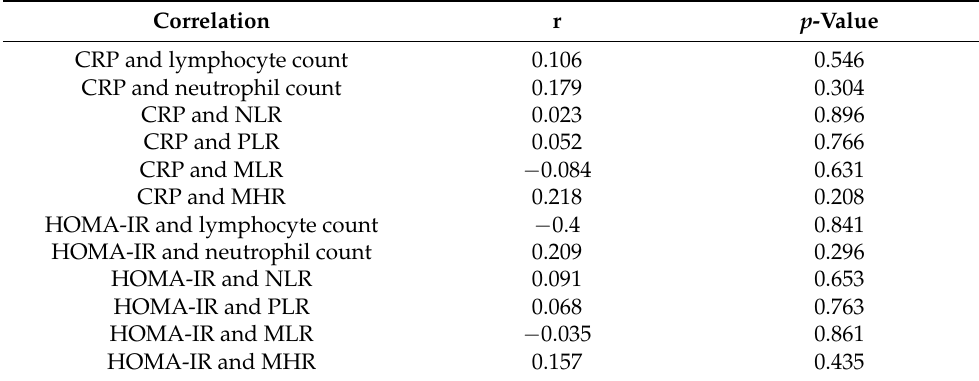
Table 4. CV biomarkers did not correlate with CRP or